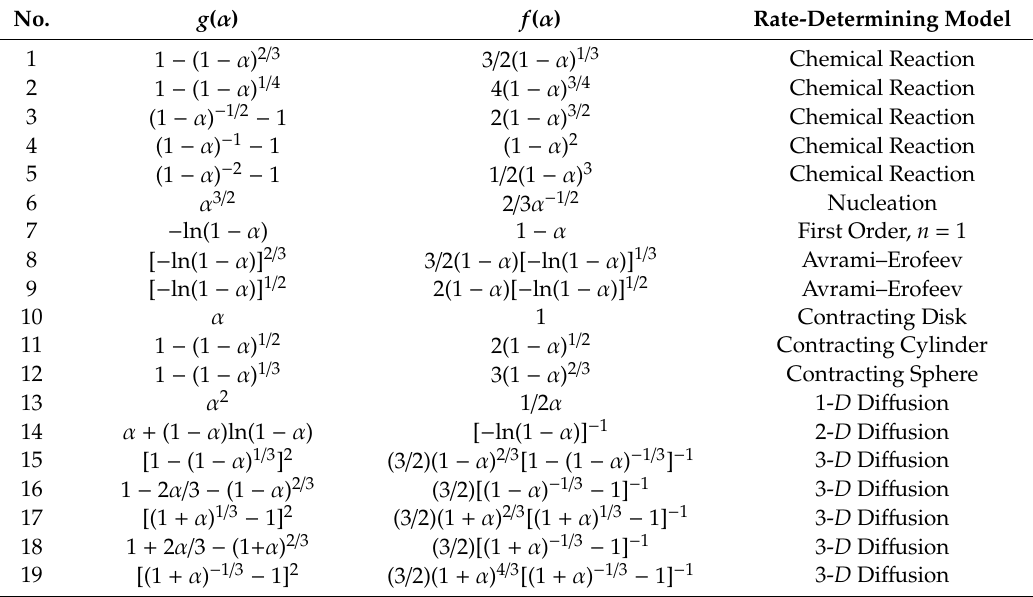
Table 1. Common solid reaction mechanisms